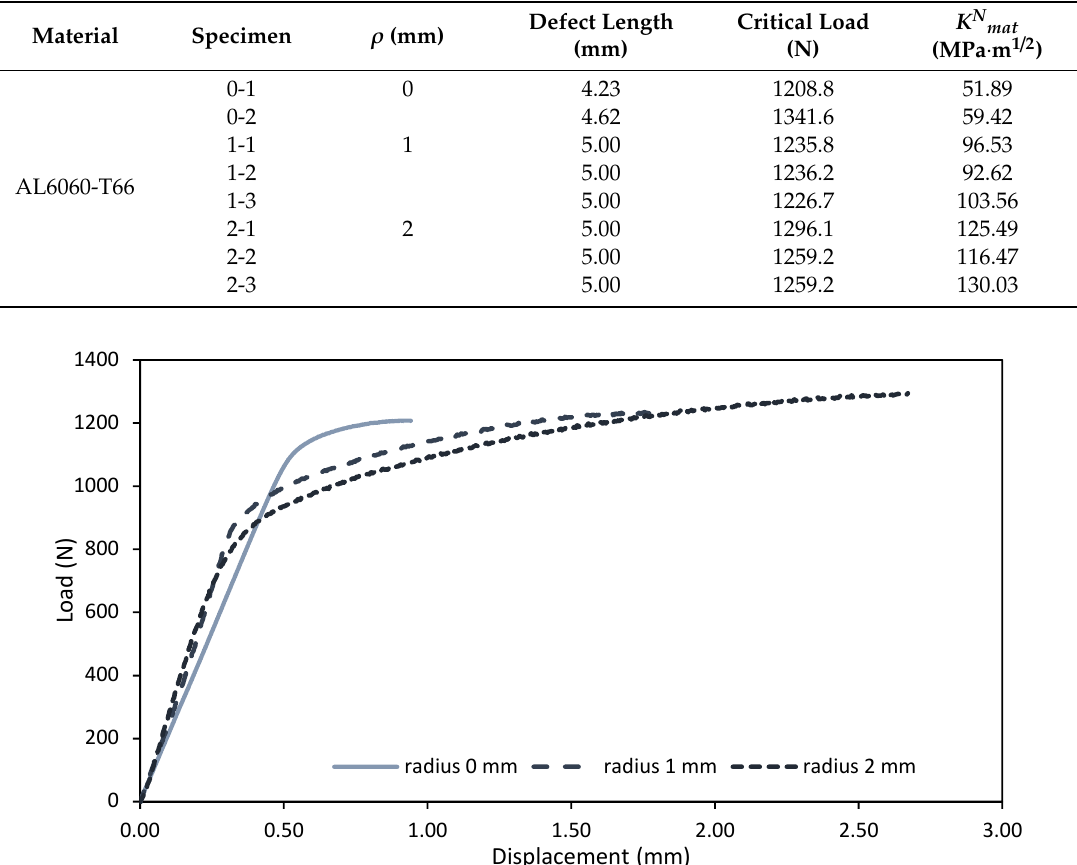
Figure 8. Load–displacement curves of some of the fracture tests.